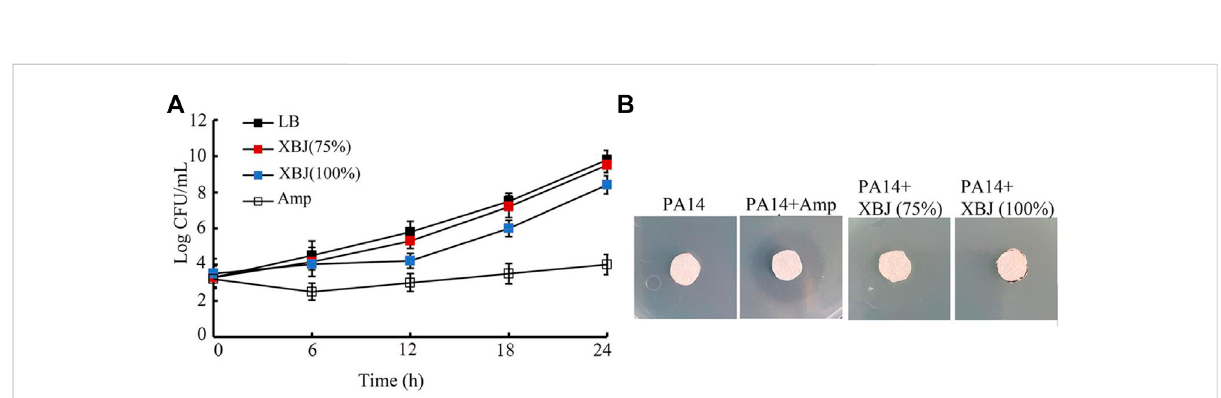
FIGURE 4 Analysis of the antibacterial activity of Xuebijing. (A) Time – kill assay. (B) Disk diffusion assay. XBJ, Xuebijing. AMP, ampicillin. AMP treatment concentration was 1 μ g/mL.